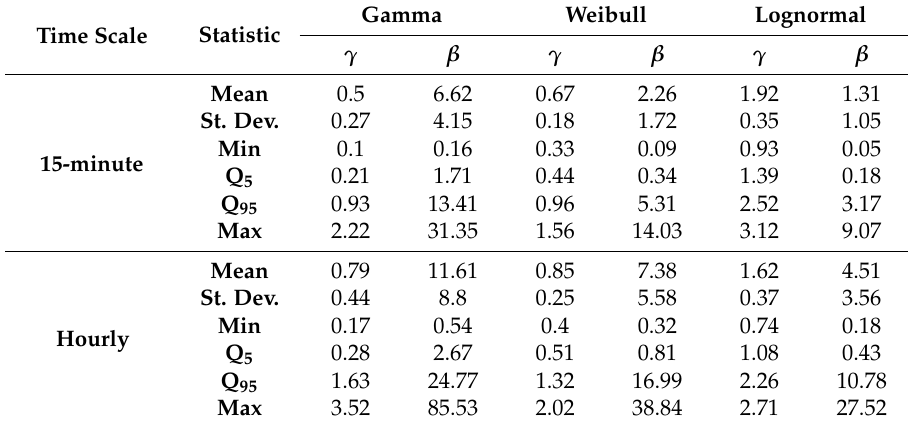
Table A6. Summary statistics of the shape and scale parameters of the three understudy distributions fitted on the individual